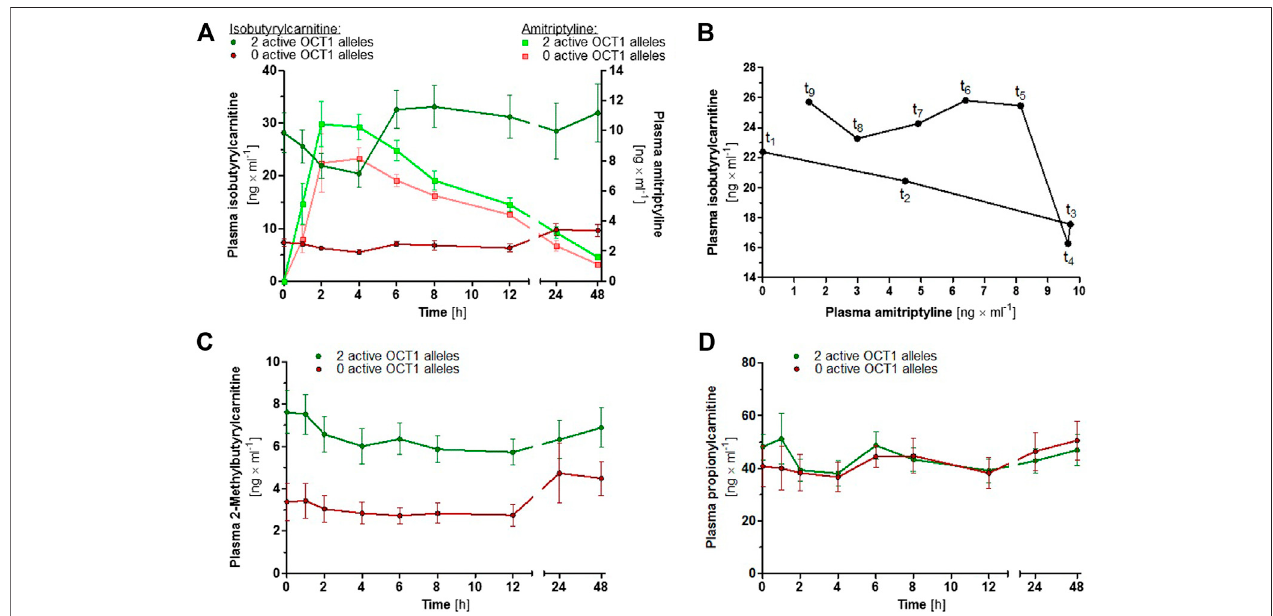
FIGURE 7 | (A) Mean ± SEM of IBC (dark coloured circles) and AT (light coloured squares) plasma concentrations over time, strati fi ed by OCT1 genotype (green datapointsrepresent twoactiveOCT1allelesandreddatapointsrepresentzeroactiveOCT1alleles;carriers ofOCT1*2werenotincluded). (B) Hysteresisplotshowing the mean plasma concentrations of AT and IBC in 13 healthy volunteers with two active OCT1 alleles. (C) Mean ± SEM of 2-methylbutyrylcarnitine and (D) propionylcarnitine plasma concentrations over time, strati fi ed by OCT1 genotype.